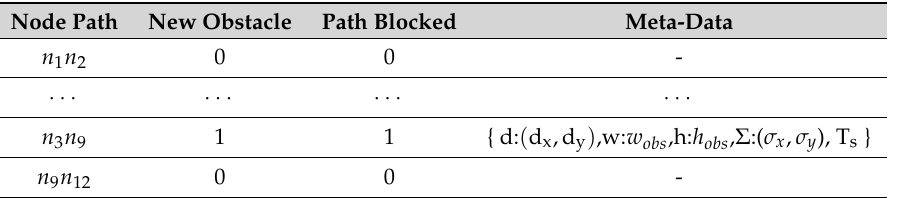
Table 2. T-node map information corresponding to Figure